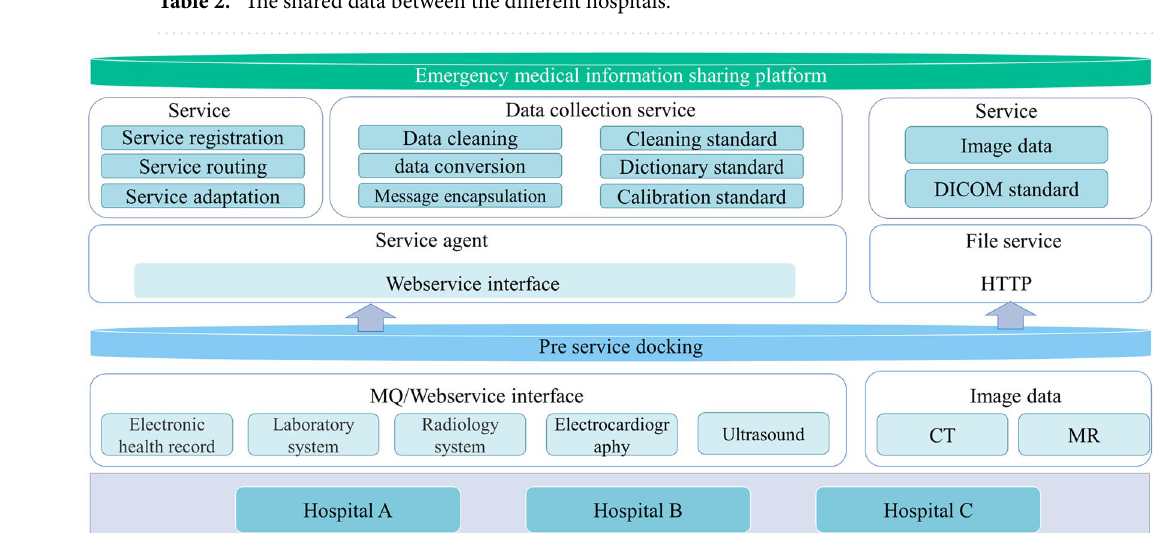
Table 2. The shared data between the different hospitals.